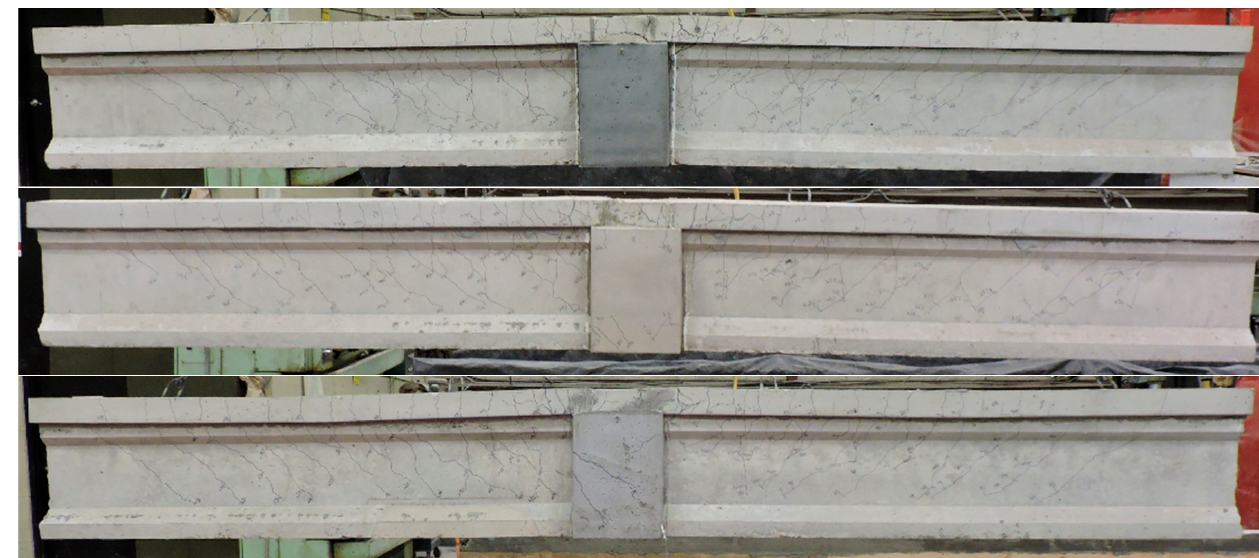
Figure 20. Repaired UHPC ( top ), FRSCC ( middle ), and MALP ( bottom ) after testing.